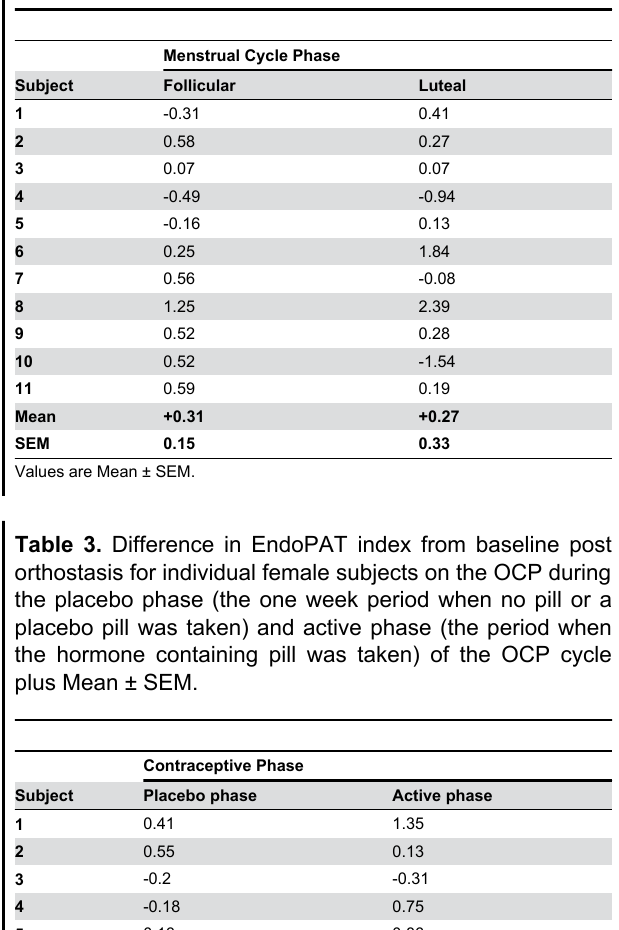
Table 2. Difference in EndoPAT index from baseline post orthostasis for individual female subjects during the follicular and luteal phases of the menstrual cycle.